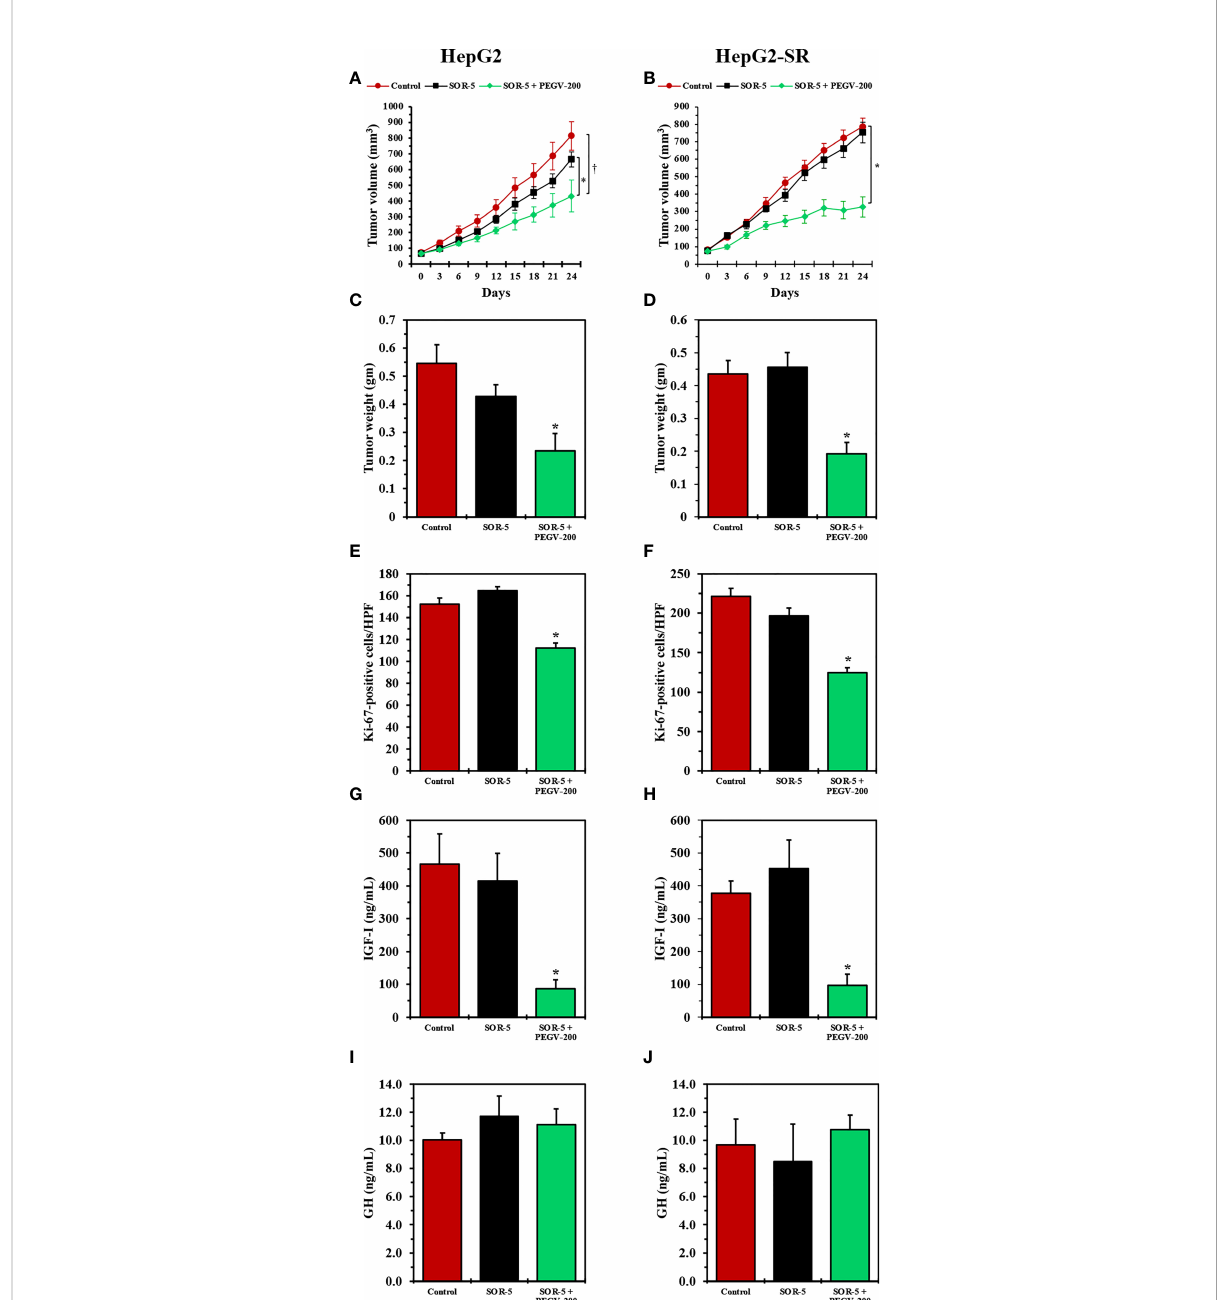
FIGURE 6 In vivo effects of antagonizing the GH/GHR signaling axis using pegvisomant in mice with sorafenib-resistant HCC xenografts. We studied the effects of SOR-5 alone vs. SOR-5+PEGV-200 in parental HepG2 tumor xenografts (left panel: fi ve males, fi ve females in the control group; four males, six females in the SOR-5 group; and fi ve males, fi ve females in the SOR-5+PEGV-200 group), and in the HepG2-SR tumor xenografts (right panel: fi ve males, fi ve females in the control group; three males, six females in the SOR-5 group; and six males, six females in the SOR-5+PEGV- 200 group). In the parental HepG2 tumors, SOR-5 induced a slight decrease in tumor growth that was not statistically signi fi cant (A) , whereas in the sorafenib-resistant HepG2-SR tumors it failed to induce any suppression in tumor growth (B) . In contrast, treatment with PEGV-200 successfully suppressed the growth of these tumors (A) *P = 0.02 vs. SOR-5; † P < 0.01 vs. control, (B) *P < 0.0001 vs. control and SOR-5. Similar effects were noted on the tumor weights (C) *P = 0.01 vs. SOR-5; P < 0.01 vs. control, (D) *P < 0.001 vs. control and SOR-5). Notably, SOR-5 alone didn ’ t decrease the proliferation of parental HepG2 tumor xenografts, whereas the addition of PEGV-200 induced a signi fi cant decrease in the proliferation of these tumors (E, F) *P < 0.0001 compared to control and SOR-5). In addition, only mice given PEGV-200 developed a marked decrease in circulating IGF-I levels (G, H) *P < 0.0001 vs. control and SOR-5). Treatment did not affect the levels of circulating GH (I, J)